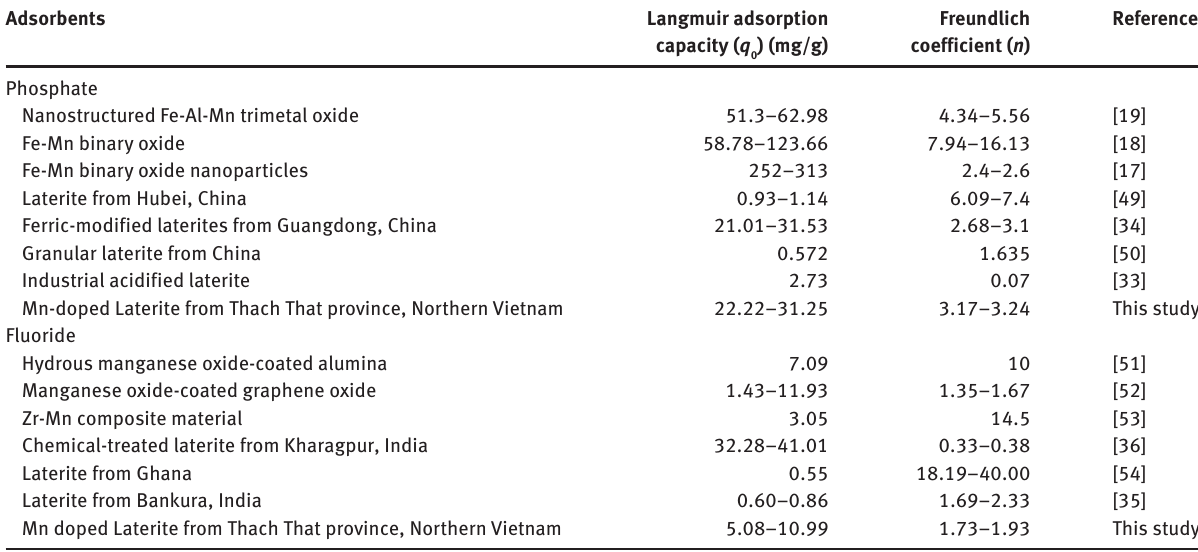
Table 3: Comparison between MDL and other material reported in some studies.